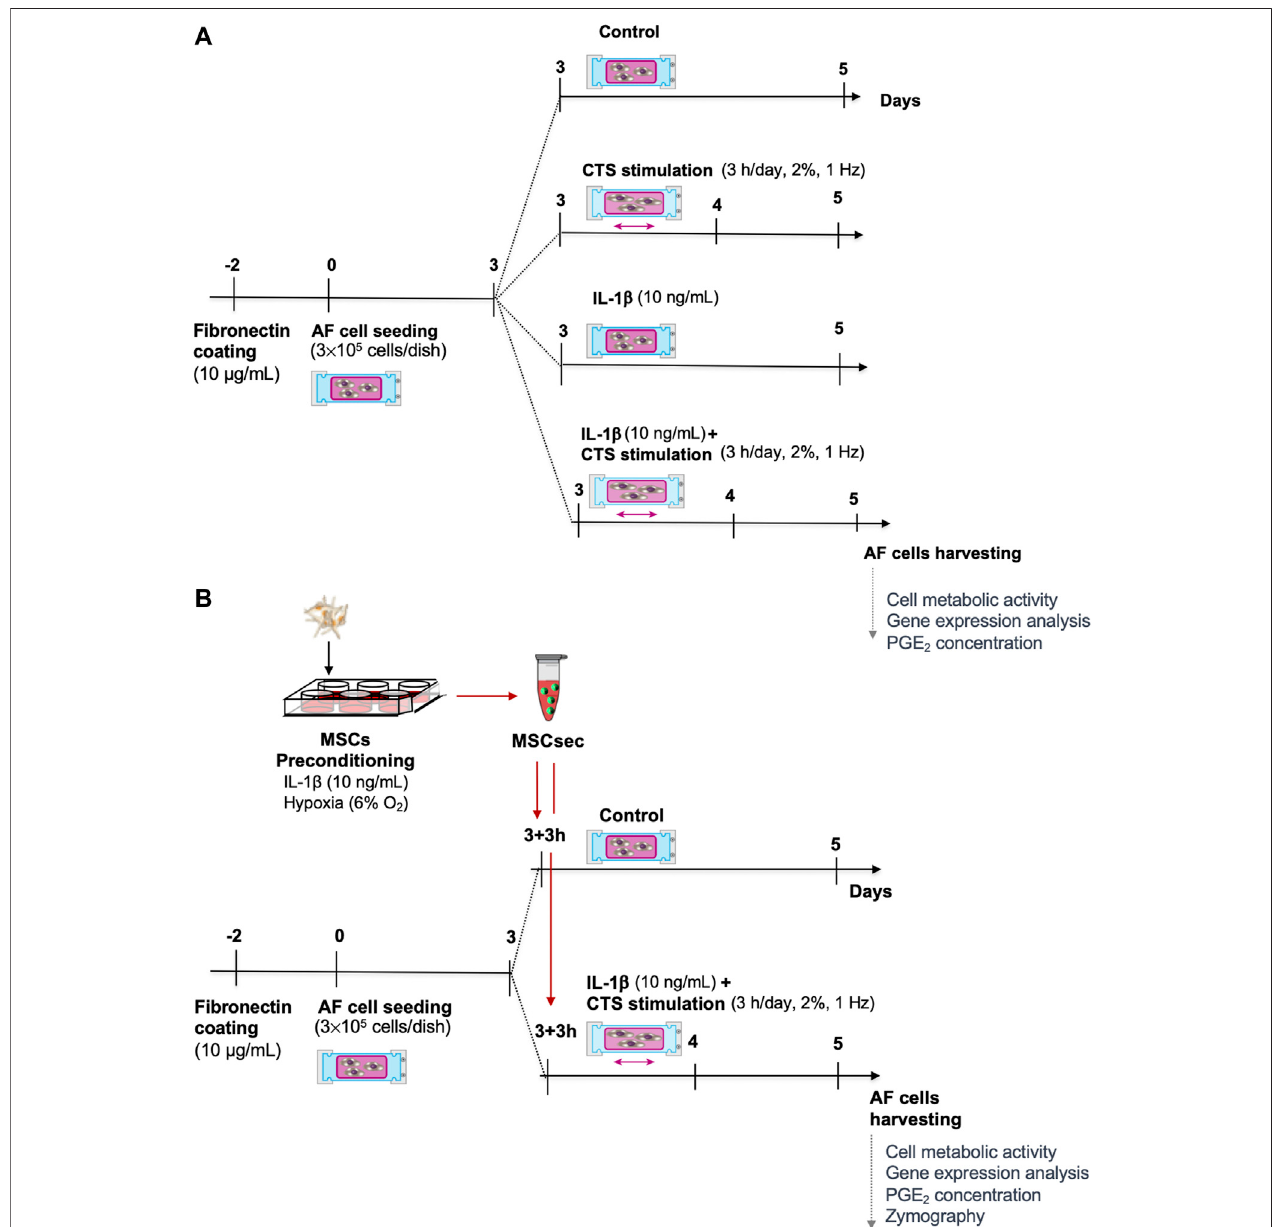
FIGURE 1 | Experimental timeline. (A) Human annulus fi brosus (AF) cells were cultured in a custom-made electromechanical device for the application of cyclic tensile strain (CTS) to deformable silicone dishes, with IL-1 β (10 ng/ml) or with CTS + IL-1 β . (B) The CTS + IL-1 β – stimulated AF cells were treated with secretome from human bone marrow – derived mesenchymal stem/stromal cells (MSC) upon preconditioning with IL-1 β for 48